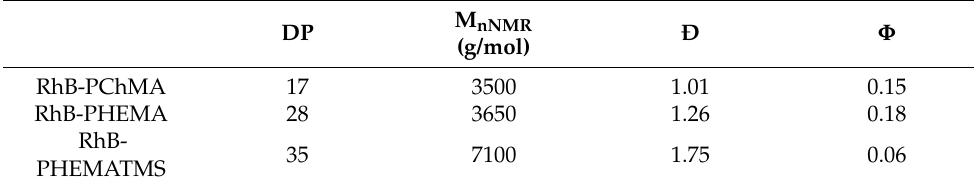
Table 1. Characteristics of obtained fluorescent polymers.